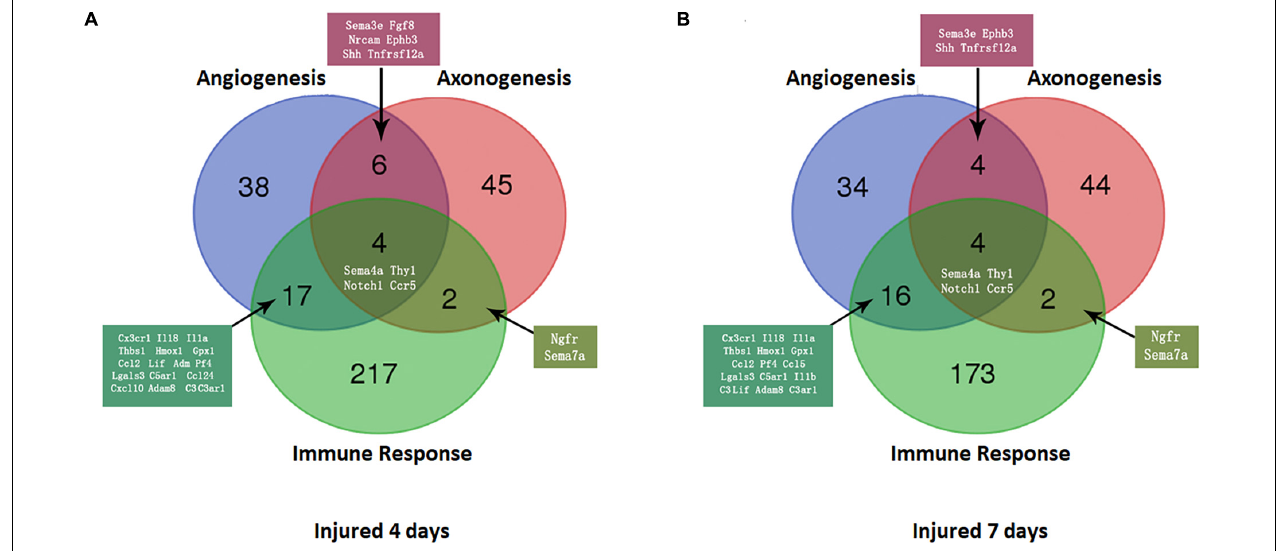
FIGURE 5 | Venn diagram of mRNAs with increased expression at the intersection of angiogenesis, axonal regeneration, and the immune response at different time points. (A) 4 days after sciatic nerve crush injury; (B) 7 days after sciatic nerve crush injury. The number and names of intersecting genes are indicated in the